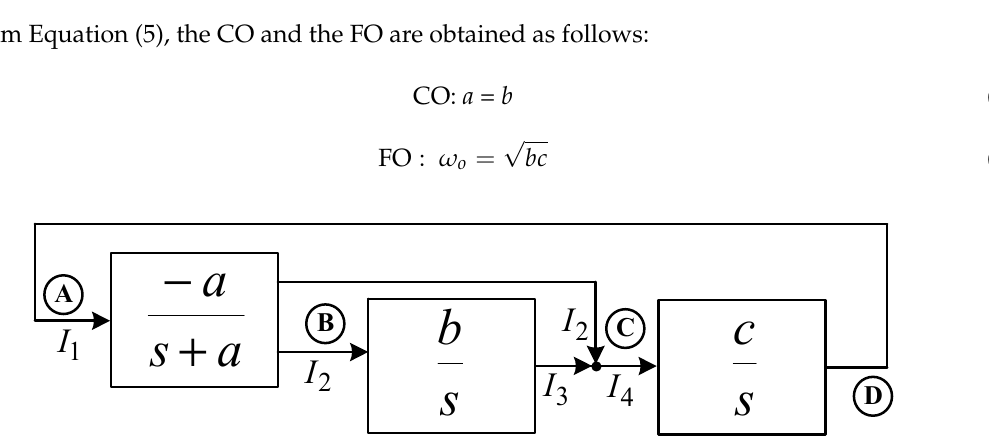
Figure 3. The proposed third-order quadrature sinusoidal oscillator. Let D = A , and the close-loop circuit analysis provides the following system characteristic equation. 0 122322 213213 =+++ mXXX gsCRCCsRRCCCs